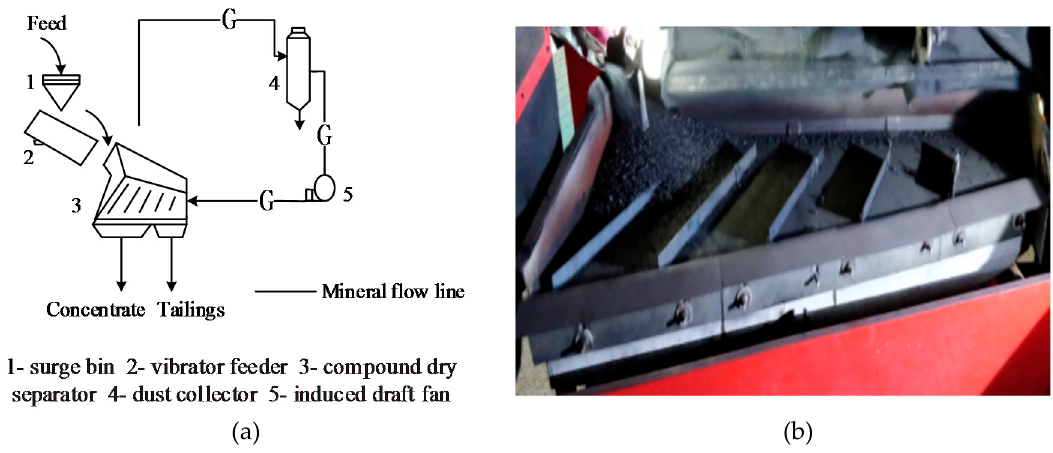
Figure 1. Flow chart of the model system of compound dry coal separation. ( a ) The schematic diagram; ( b ) the equipment diagram.